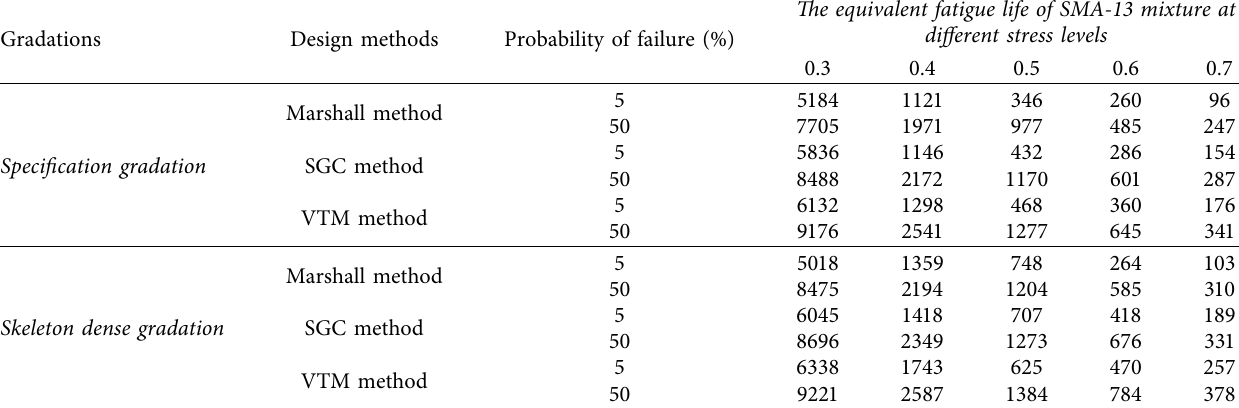
Gradations Design